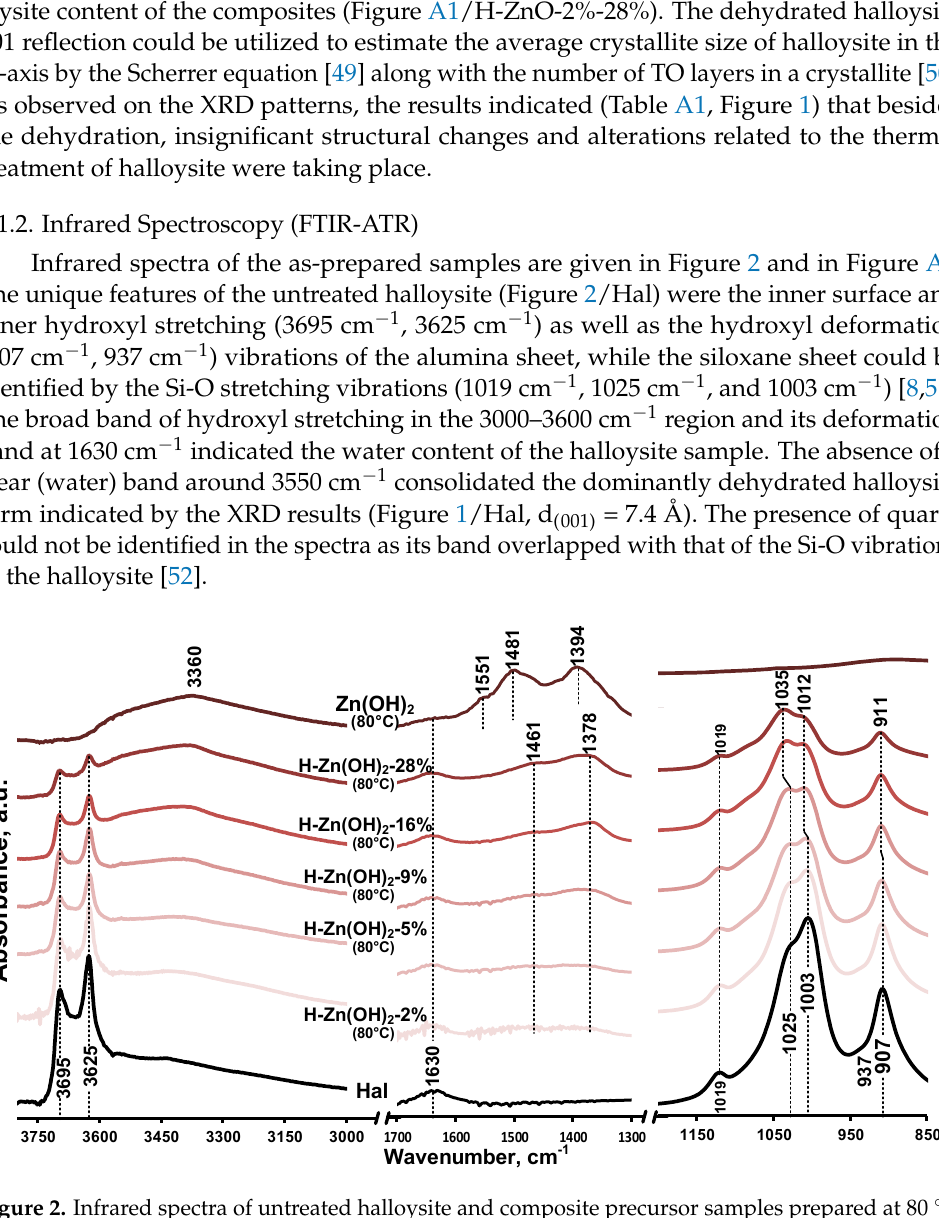
Figure 2. Infrared spectra of untreated halloysite and composite precursor samples prepared at 80 °C in the 3800–3000 cm − 1 , 1700–1300 cm − 1 , and 1200–850 cm − 1 spectral region.